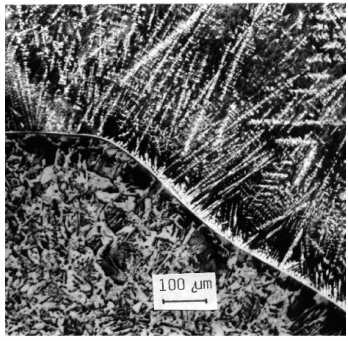
Figure 9. Cast structure of hardfacing weld E 518 B.